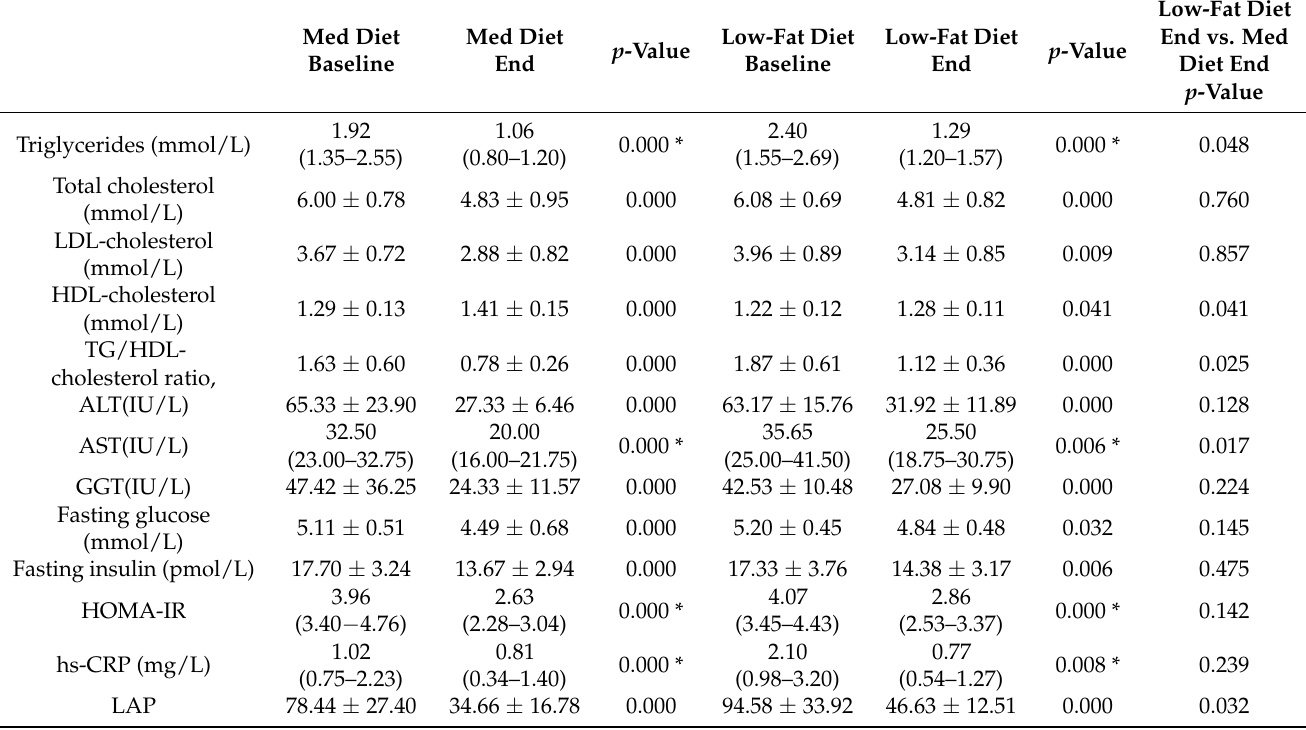
Table 2. The baseline biochemical serum parameters in NAFLD patients and the changes induced by dietary